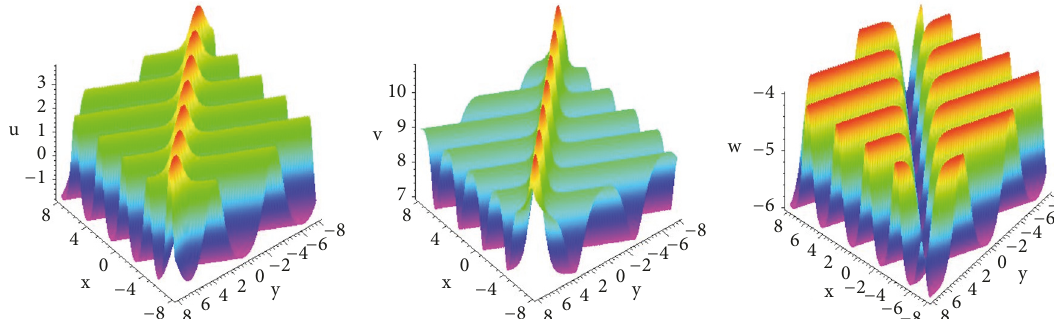
Figure 4: The 𝑢, V , and 𝑤 plots of the soliton-cnoidal wave interaction solution (42), (43), and (44),